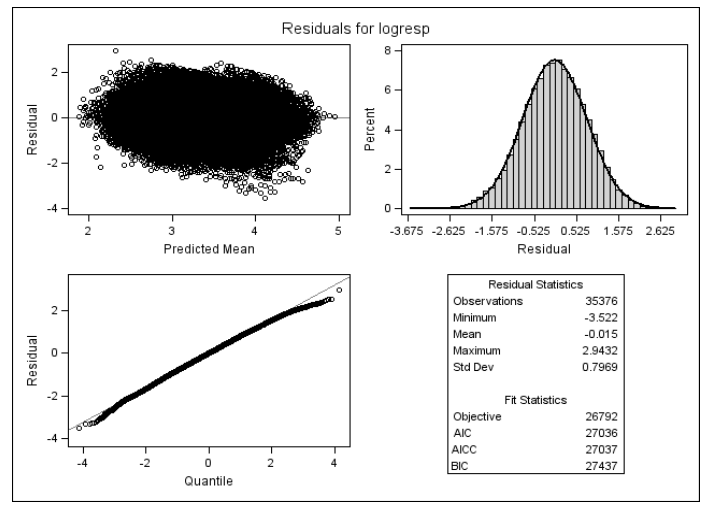
Figure 3. Standardised residuals of the multivariate mixed linear model.